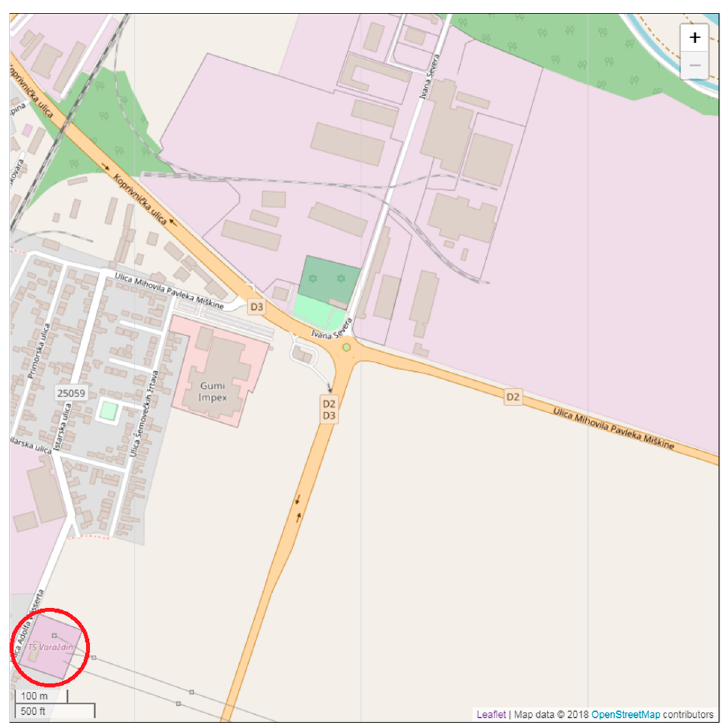
Figure 4 Varaždin industrial area-Open Street Map image. Figure 4. Varaždin industrial area-Open Street Map image.